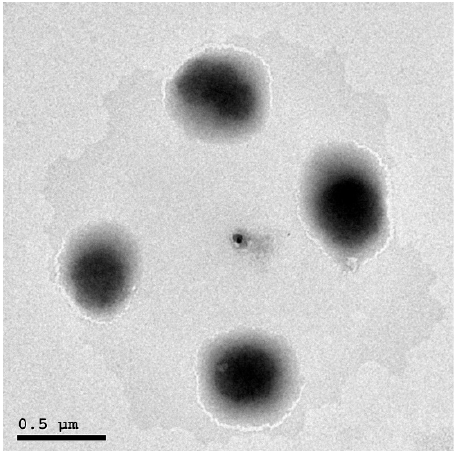
Figure 2. TEM photomicrograph of the optimized valsartan-loaded ethosome